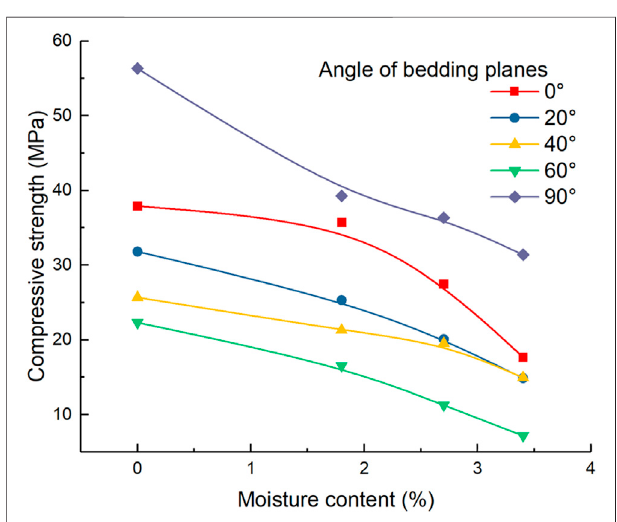
Frontiers in Earth Science |